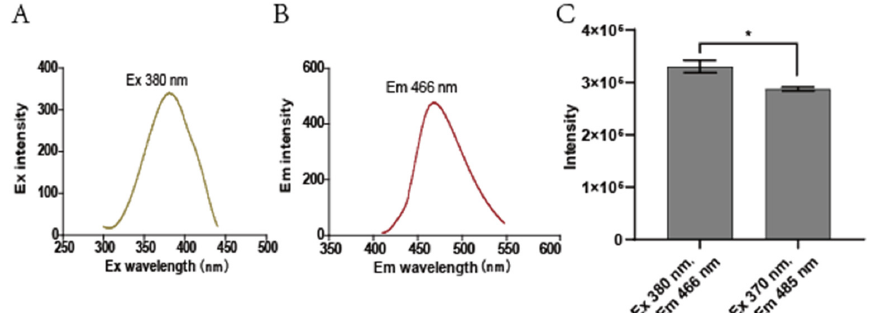
Figure 2. The optimal excitation and emission wavelengths of bimane-S 2 O 32 − . 0.05 mM S 2 O 32 − was reacted with 0.25 mM mBBr to ensure S 2 O 32 − was converted to bimane-S 2 O 32 − . This reaction solution was used to search for the optimal excitation and emission wavelengths. ( A ) Fixed Em at 485 nm to screen the Ex from 300 nm to 440 nm. ( B ) Fixed Ex at 370 nm to screen the Em from 410 nm to 550 nm. ( C ) The comparison of the peak area of bimane-S 2 O 32 − detected with the optimized and original fluorescence detection parameters, respectively. Three parallel experiments were performed to obtain the averages and standard deviations (n = 3). A t -test was performed to calculate the p -value. Symbol * was shown when p < 0.05.